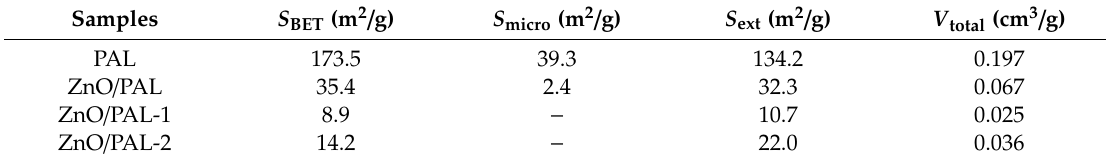
Table 1. S BET , S micro , S ext and V total of PAL, ZnO/PAL, ZnO/PAL-1 and ZnO/PAL-2.